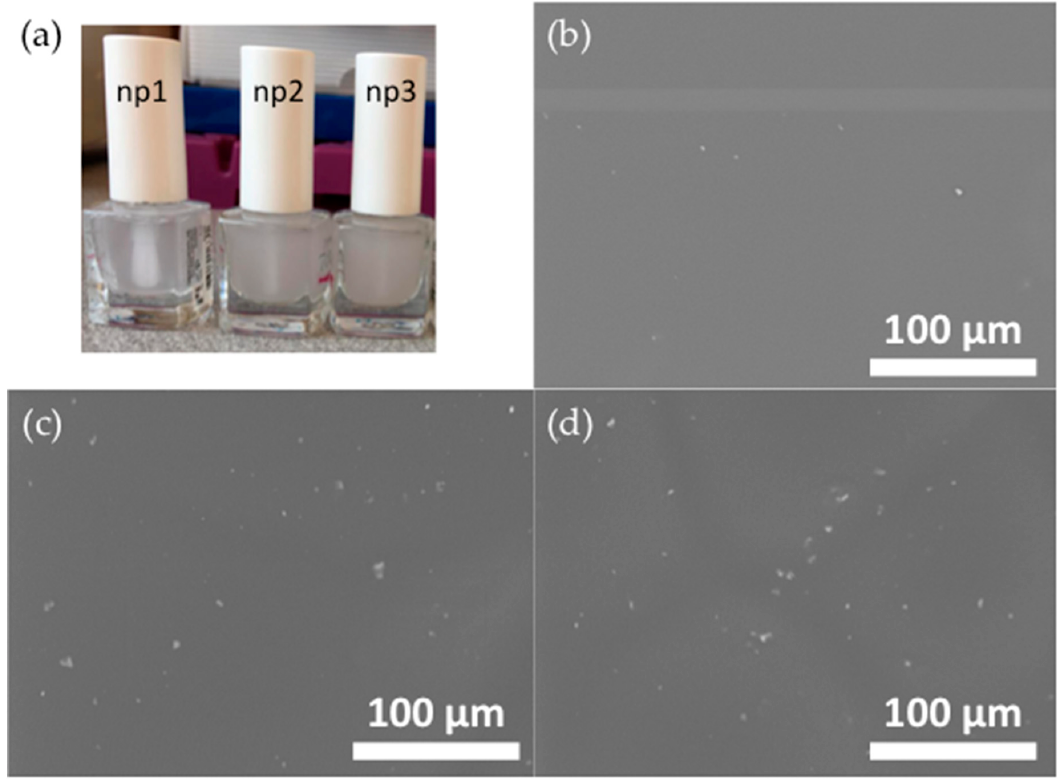
Figure 2. Photography of ( a ) the modified nail polish formulations and SEM micrographs of the dry modified nail polish formulations: ( b ) np1, ( c ) np2, and ( d ) np3.